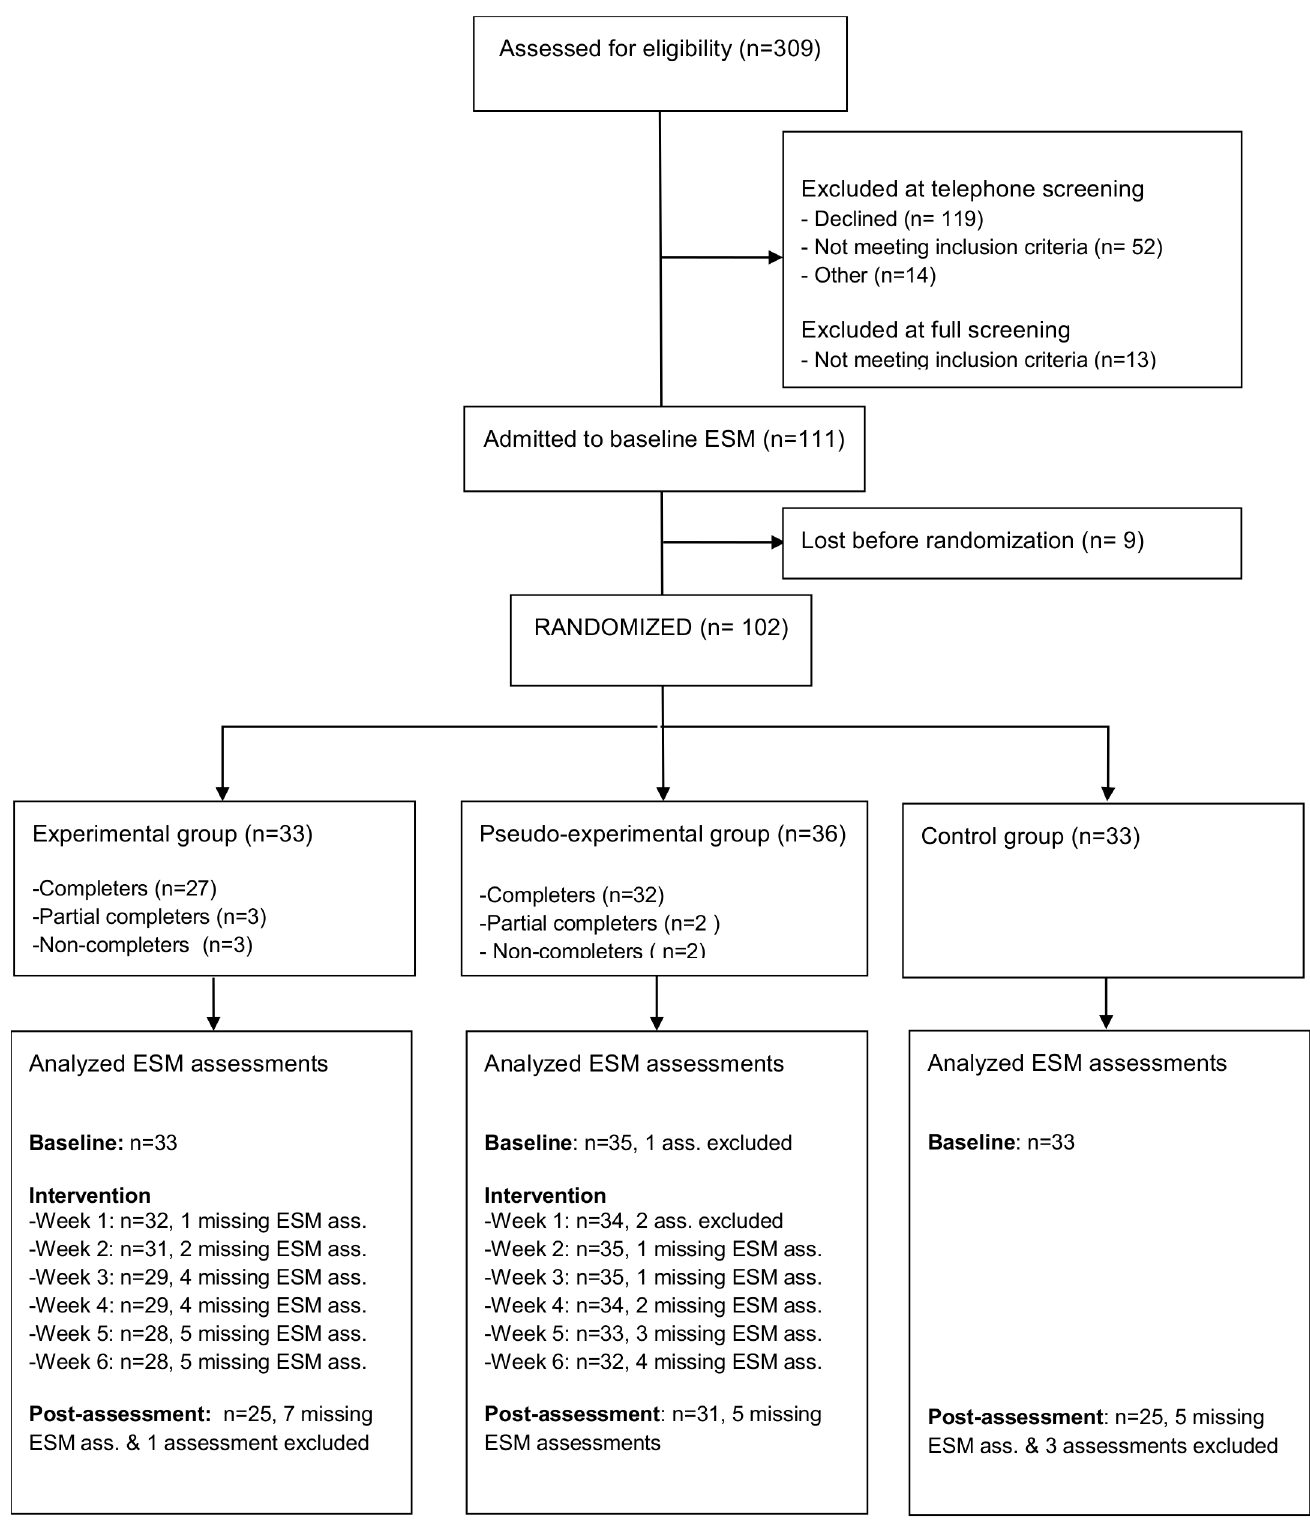
Fig 1. Participant flow diagram. Completer: Participant who attended all six intervention sessions; Partial Completer: Participant who attended less than six intervention sessions but did not withdrew from the study; non-completer: Participant who attended less than six intervention sessions and withdrew from the